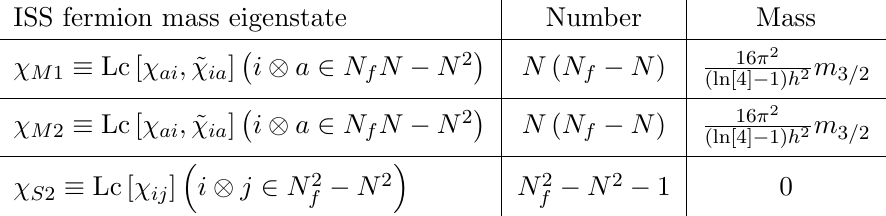
Table 2 . Tree-level largest contributions to the masses of the ISS fermion eigenstates within the index space i (cid:10) a 2 N 2 and i (cid:10) j 2 N 2 . The notations i (cid:10) a and i (cid:10) j are of the same type as the ones for the ISS scalar masses table 1. Furthermore, Lc stands for the linear combinations given from equations (2.49) to (2.57), and the second column gives the number of ISS fermions mass eigenstates in the considered index space.